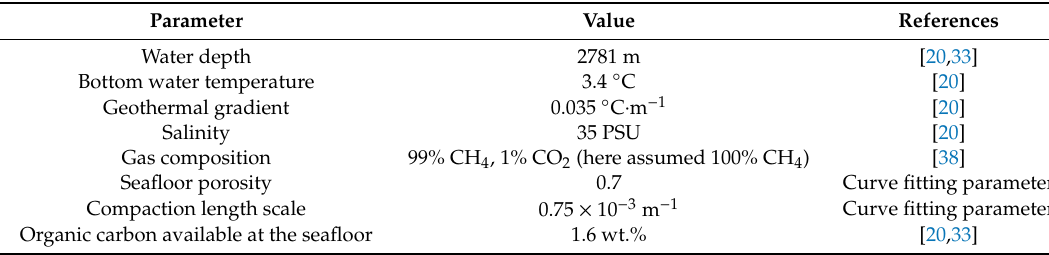
Table 1. Blake Ridge Site 997 characterization.